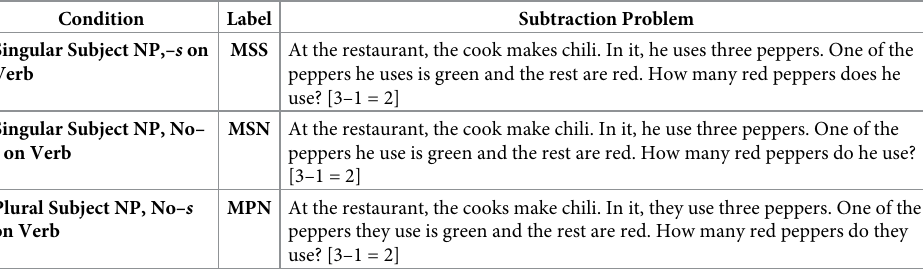
Table 10. Example auditory stimuli for the mathematical reasoning experiment (subtraction